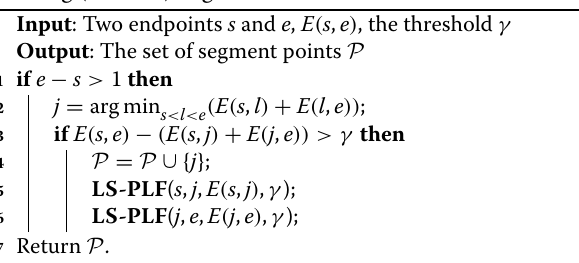
Algorithm 2: Least-Squares Based Piecewise Linear Fitting (LS-PLF) Algorithm